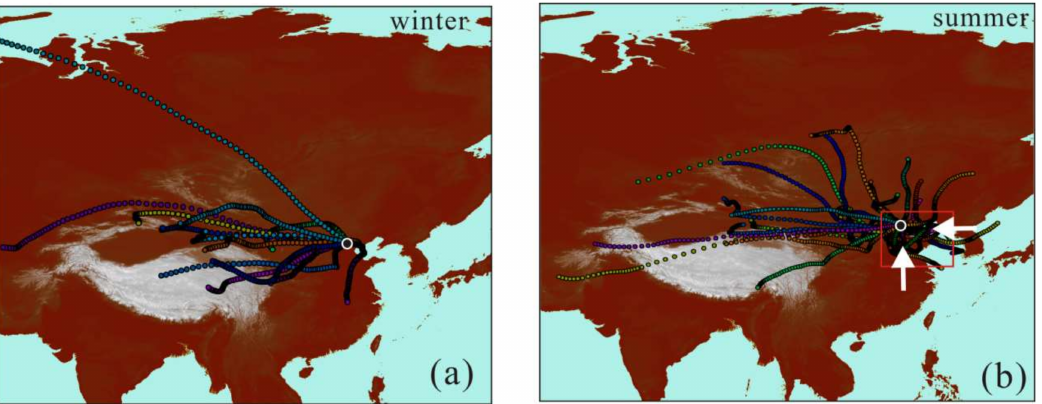
Figure 6. Moisture trajectories obtained from the HYSPLIT model through the layer from the surface to 1500 m for 72 h at the beginning of precipitation during the ( a ) winter and ( b ) summer seasons. The white point indicates BTC station. The rectangle covers the moisture trajectories from south and